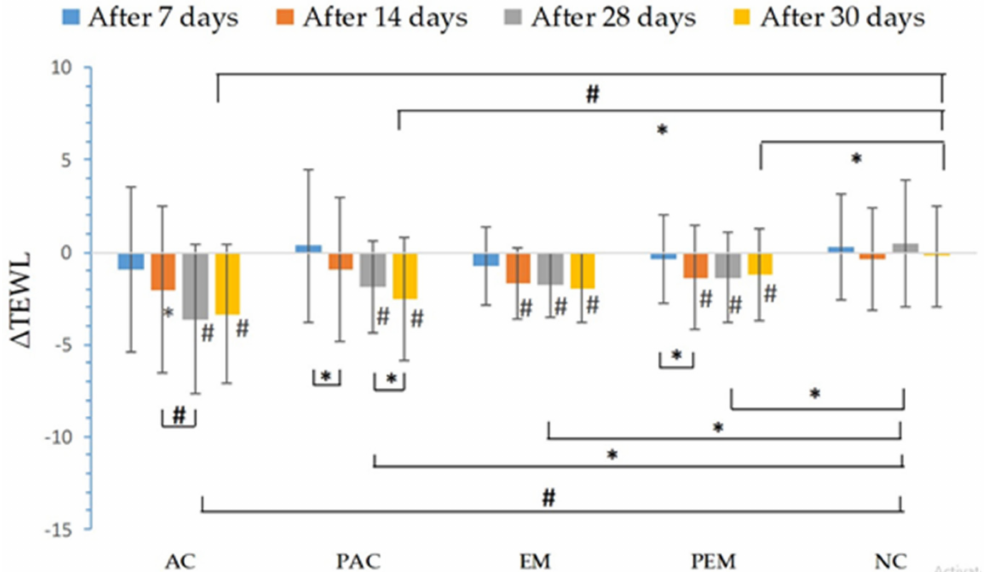
Figure 3. In vivo determined absolute changes relative to basal values of trans-epidermal water loss (TEWL) for investigated creams (active cream—AC, placebo cream—PAC) and emulgels (active emulgel—EM, placebo emulgel—PEM) after 7, 14, and 28 days of application, and 2 days after cessation of application. Significant differences are marked with # ( p < 0.01) and * ( p <